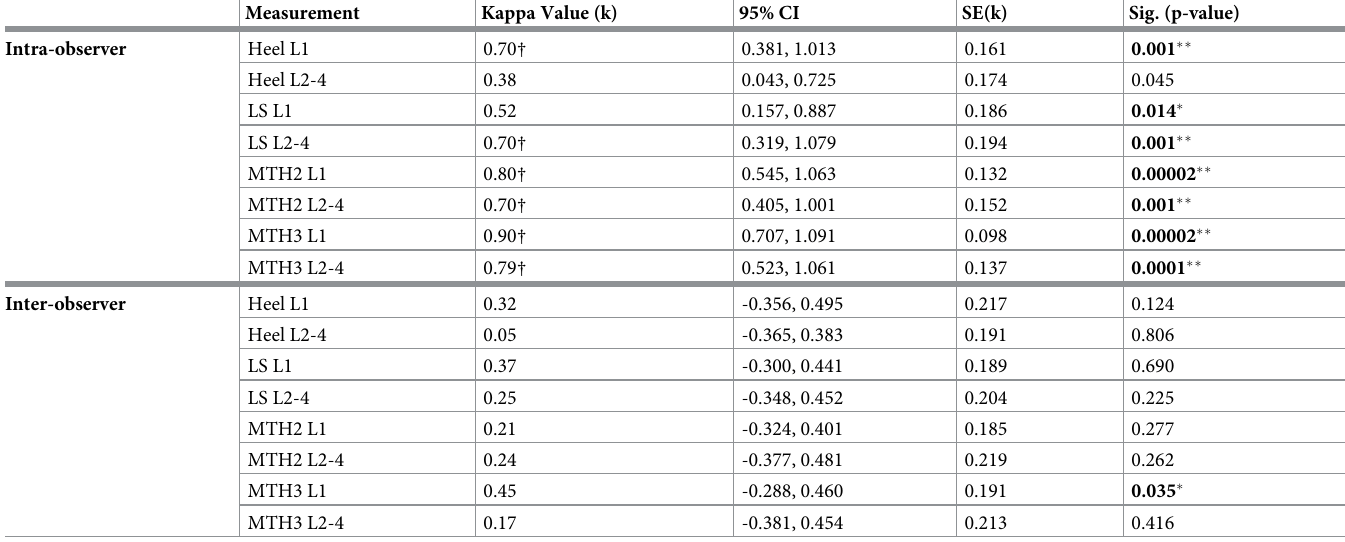
Table 6. Results of inter- and intra-observer agreement for skin and fat pad tissue characteristic assessments.